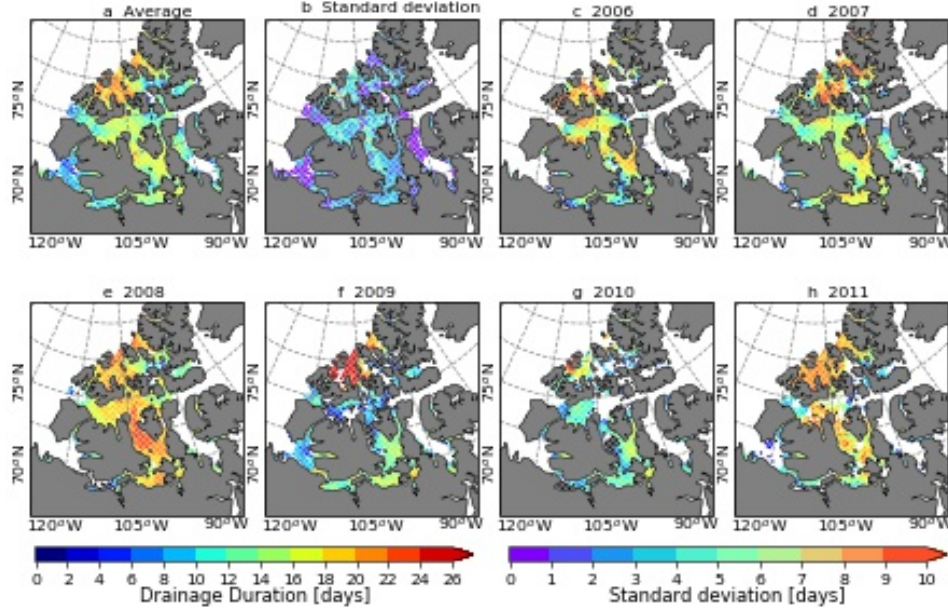
Figure 9. Same as Figure 8, but for drainage duration